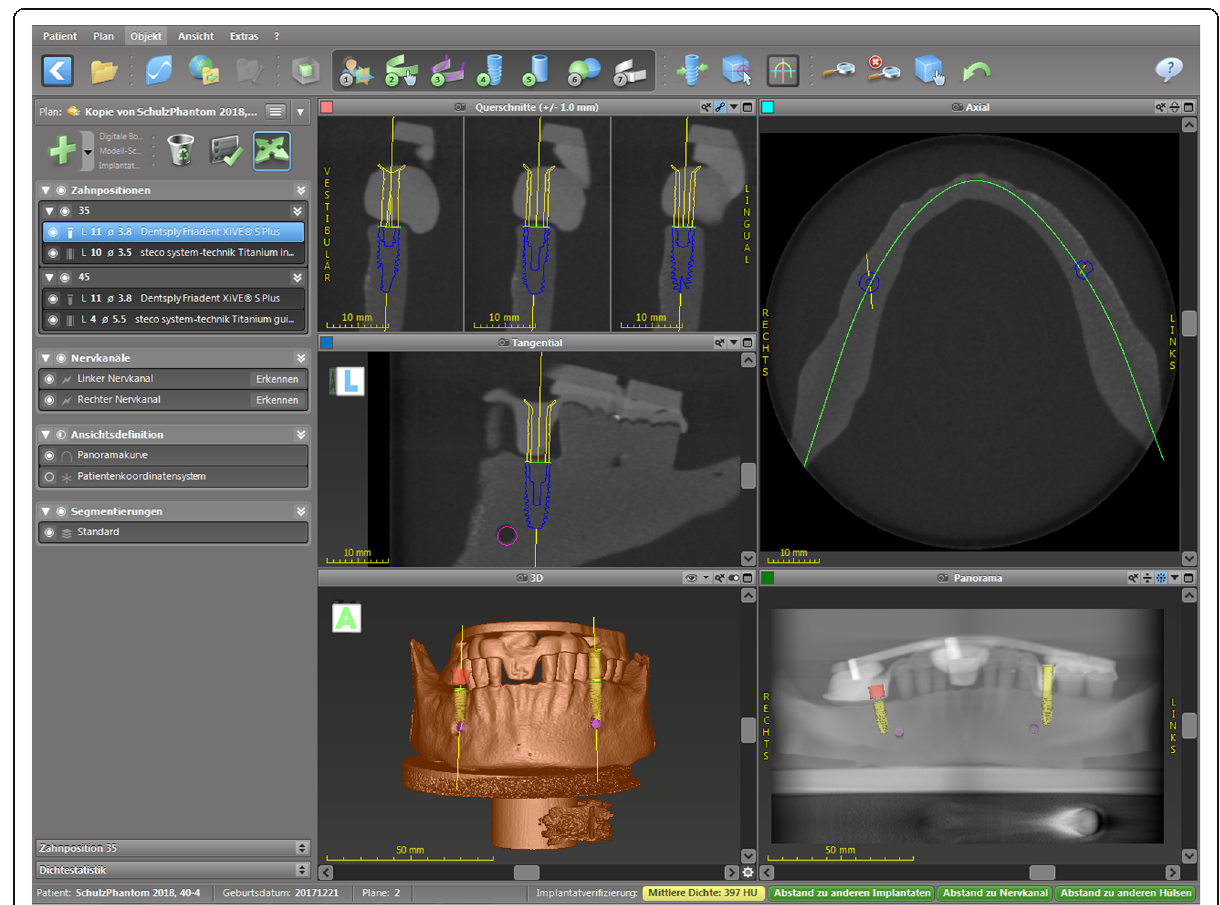
Fig. 1 Virtual planning of the implant position and angulation in region 35 and 45 using the coDiagnostiX TM software. Images in clockwise order: upper right — horizontal plane. The green elliptical line depicts the panoramic curve. Lower right — panoramic view of the mandibular model with virtually inserted implants in region 35 and 45. Lower left — three-dimensional reconstruction of the mandibular model. Center left — lateral aspect of the virtually planned implant in region 35. The pink circle located anterior-caudal of the implant depicts the mental foramen. Upper left — anterior aspect of the virtually planned implant in region